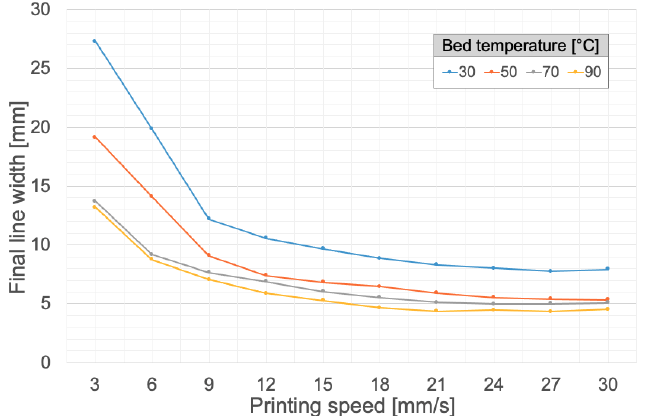
Figure 3. Influence of bed temperature and printing speed on the final line width. Silicone: Ecoflex 00-20. Needle diameter: 1.6 mm. Extrusion speed: 0.05 mm/s.